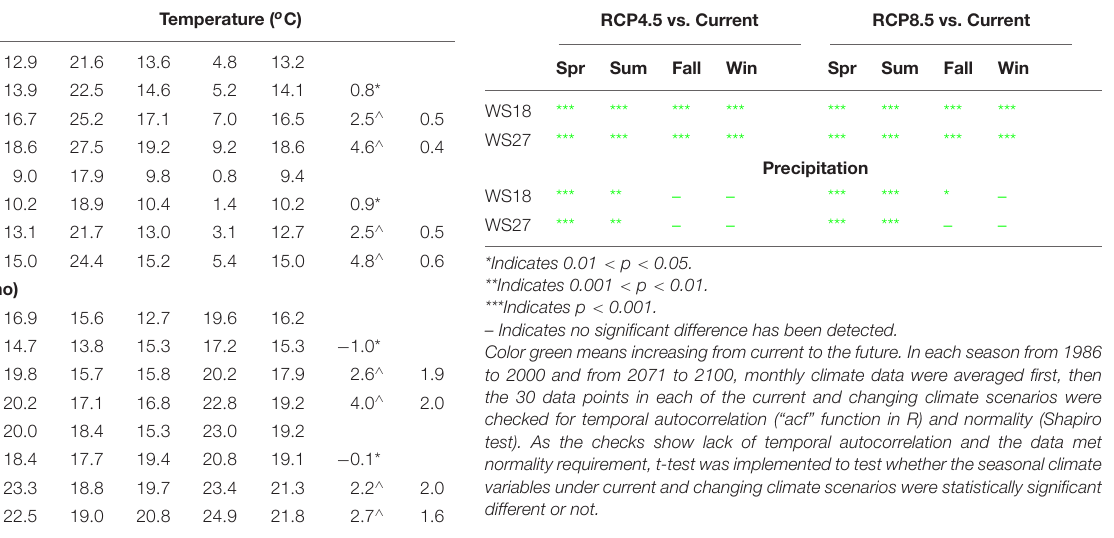
TABLE 2 | Comparison of observed and simulated streamflow (unit: cm/month) and stream chemistry variables (unit: µ mol/L) at WS18 and WS27.